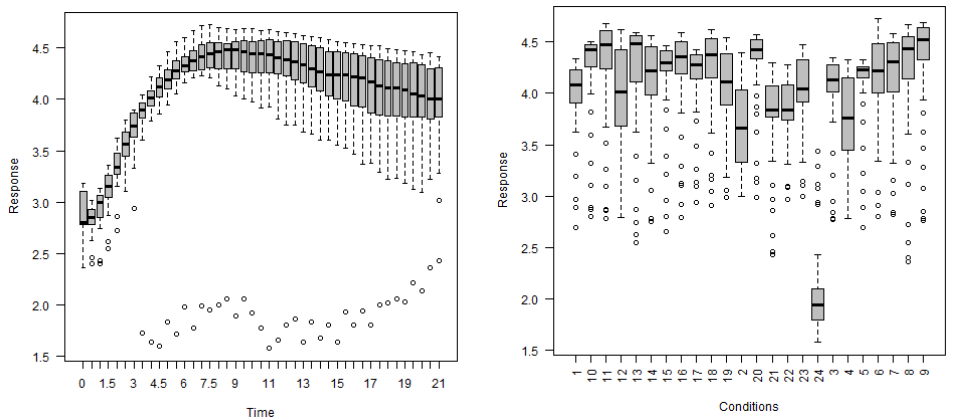
Figure 14. Box-plots of gene expressions PA0573(E6) regarding time ( left ) and conditions ( right ).